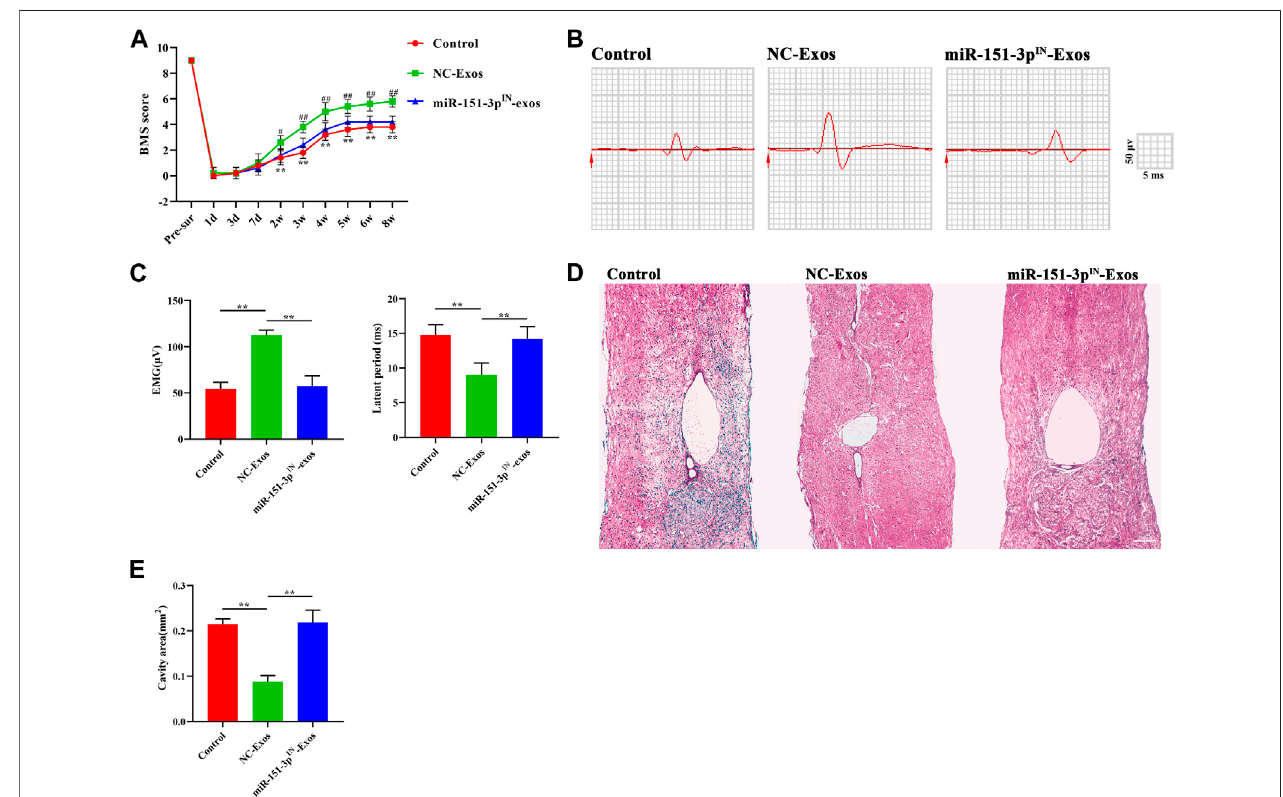
FIGURE 8 | Microglia-Exos promote neurological function healing after SCI via transfer of miR-151-3p . (A) BMS scores in control, Microglia-Exos, and miR-151- 3p IN - Microglia-Exo – treated groups at different time points. N (cid:1) 5 per group. (B) Neuroelectrophysiology analysis of control, microglia-Exos, and miR-151-3p IN - Exo – treatedgroupsat8 weeksafterinjury. (C) Quanti fi cationofmotorevokedpotential(MEP)andlatentperiodin (B) .N (cid:1) 5pergroup. (D) RepresentativeimagesofHE stainingofcontrol,microglia-Exos,andmiR-151-3p IN -Exo – treatedgroups.Scalebar:200 μ m. (E) Quanti fi cationofthecavityareaof (D) .N (cid:1) 5pergroup.Dataare presented as the mean ± SD. * p < 0.05, ** p <